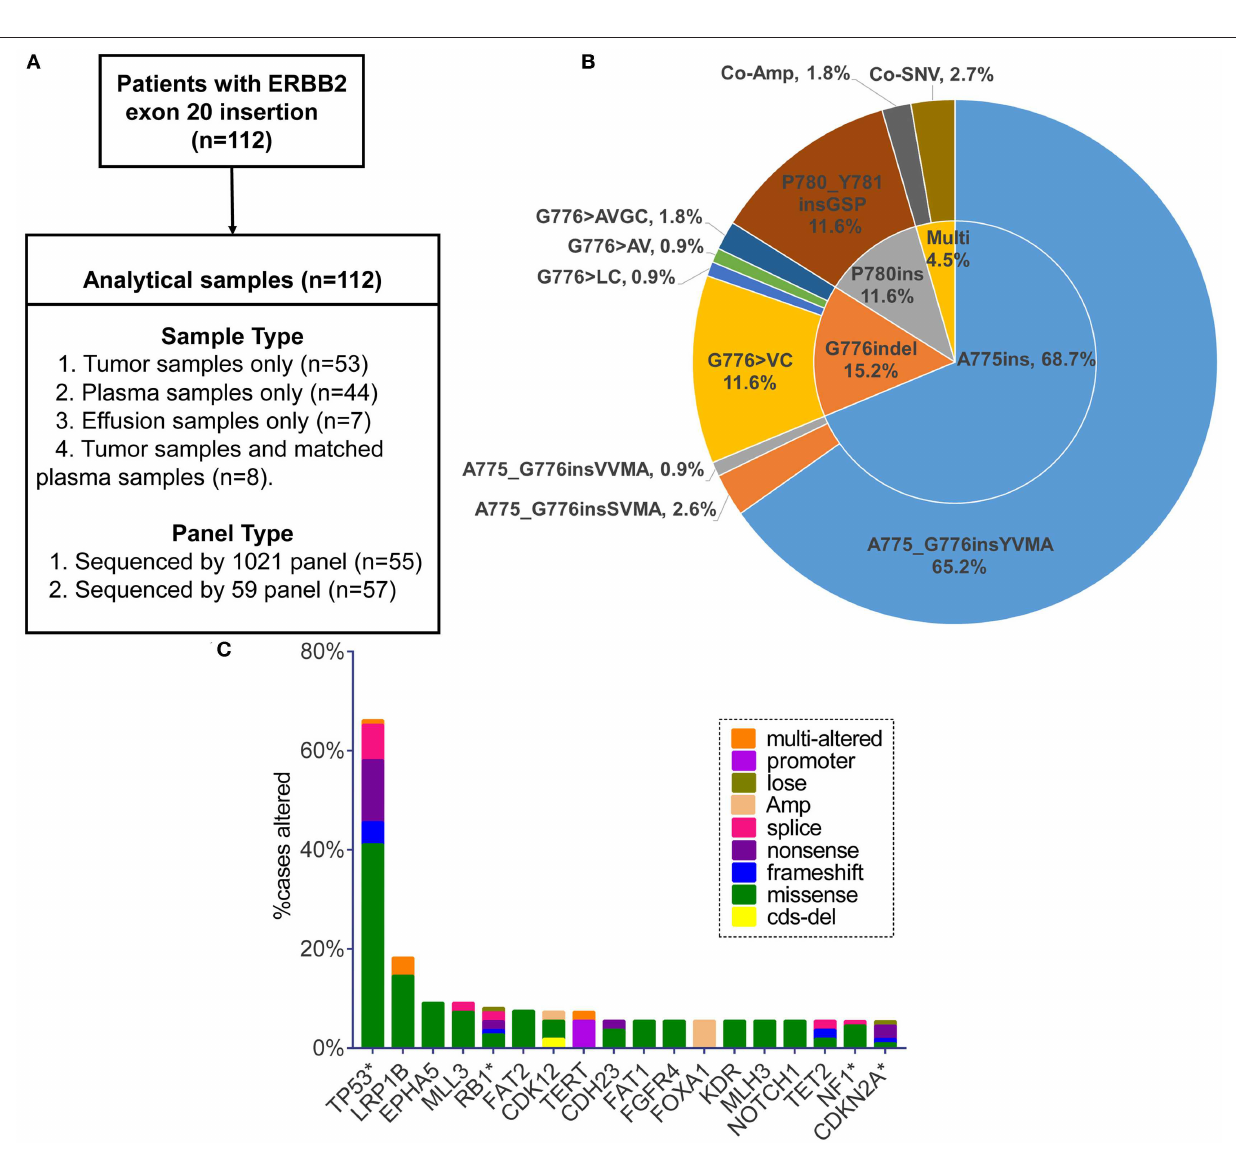
analysis. Patients were administered afatinib depending on their performance status and other comorbidities at a starting dose of 30, 40, or 50 mg daily. Best response evaluation was assessed according to the Response Evaluation Criteria in Solid Tumors (RECIST, v1.1). The progression free survival (PFS) for afatinib treatment was defined as the time from the start of afatinib treatment to the date of disease progression or death.